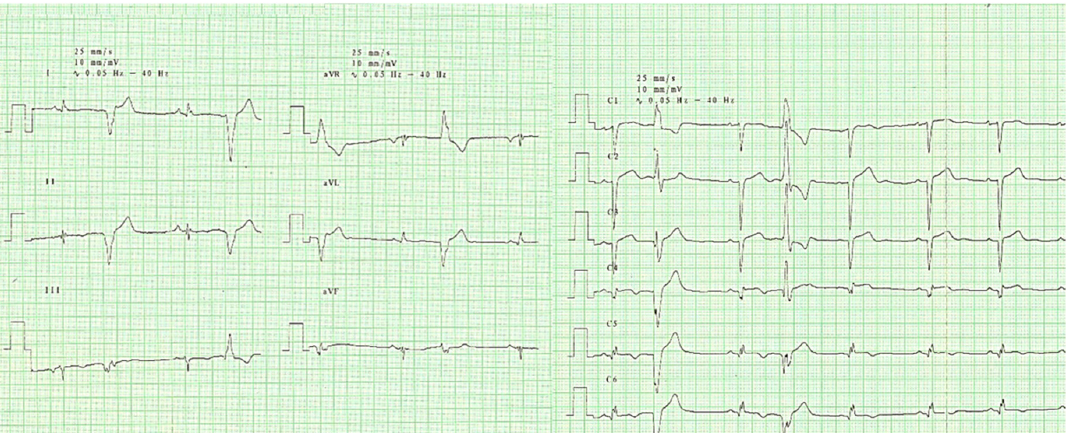
Figure 1. Electrocardiogram revealing sinus rhythm, 58 bpm, intermediate electric axis, amputated R waves in V1–V4, notched R-wave, resembling the letter “M” in V5–V6, with an QRS complex of 110 milliseconds and polymorphic premature ventricular complexes.